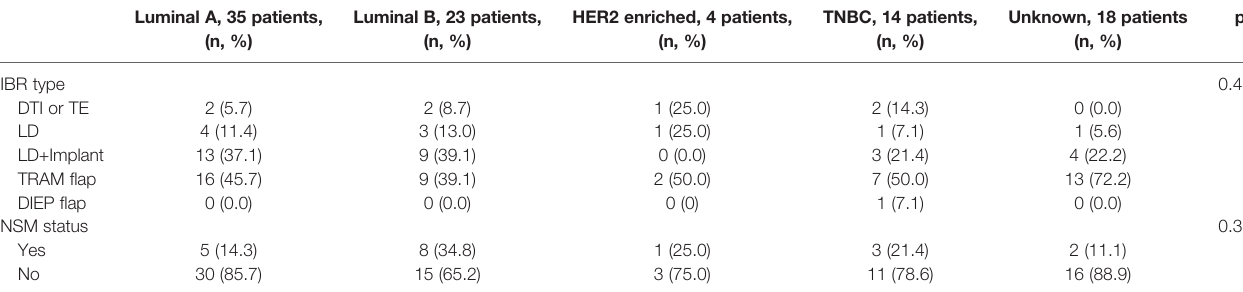
TABLE 2 | Reconstruction type and NSM status in Mx+IBR group patients. Luminal A, 35 patients, (n,